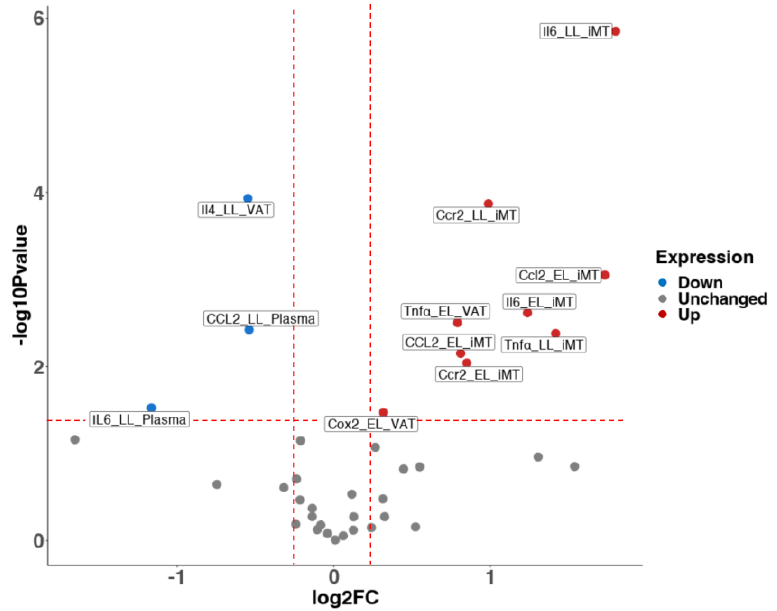
Figure 4. Volcano plot for the effect of high-fat diet in early life on inflammatory cytokine profile and metabolic parameters later in young adulthood. Red and blue points mark significantly increased or decreased expression, respectively, in HF (60 kcal % fat) vs. LF groups (10 kcal % fat) ( p < 0.05). The x -axis shows log2(fold-changes) in expression and the y -axis shows the log10(p-value). Data represents mRNA or protein expressions in plasma and tissues. iMT: inguinal Mammary Tissue. VAT: Visceral White Adipose Tissue. EL: Early Life groups; LL: Later Life groups. N = 8 – 11 animals/group.